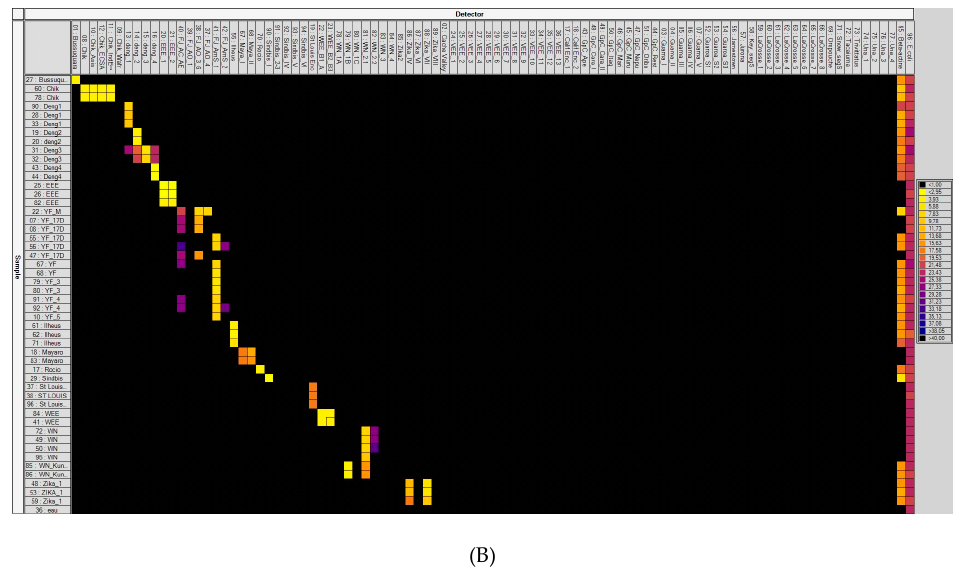
Figure 1. BioMark TM dynamic array system specificity test (96.96 chip). Specificity of primers/probe sets from the Table S1 are presented in two figures, ( A ) and ( B) . Fifty-one sets of primers/probe targeting viruses are presented in (A) and 94 sets in (B), some of them are present into both figures. Each square corresponds to a single real-time PCR reaction, where rows indicate the pathogen in the positive control and columns represent the targets of each primer/probe set. C t values for each reaction are indicated in color; the corresponding color scale is presented in the legend on the right. The darkest shade of blue and black squares are considered as negative reactions with C t > 30. chik: Chikungunya; deng: